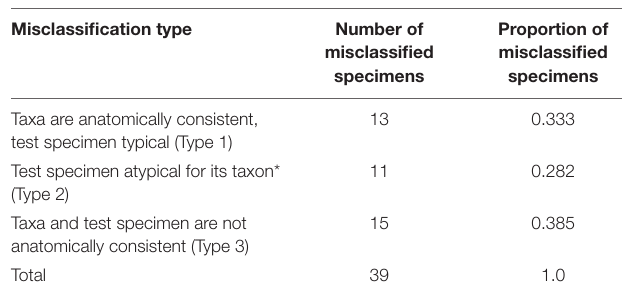
TABLE 4 | Number and proportion of misclassified specimens from Figure 2 when categorizing into one of three misclassification